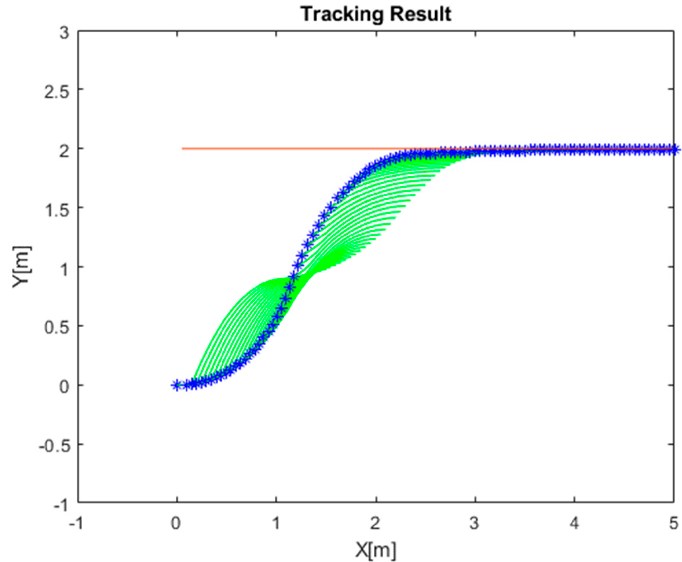
Figure 6. Line path tracking with RL-trained MPC parameters.